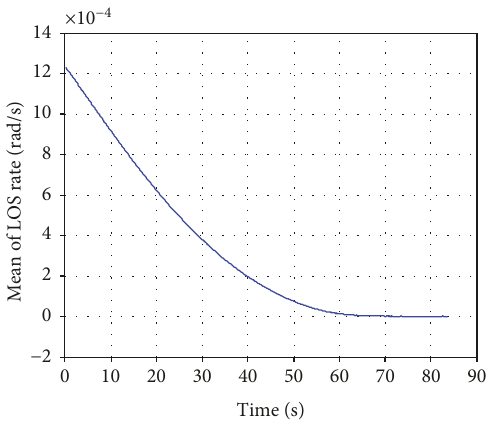
Figure 6: Mean of the LOS rate.